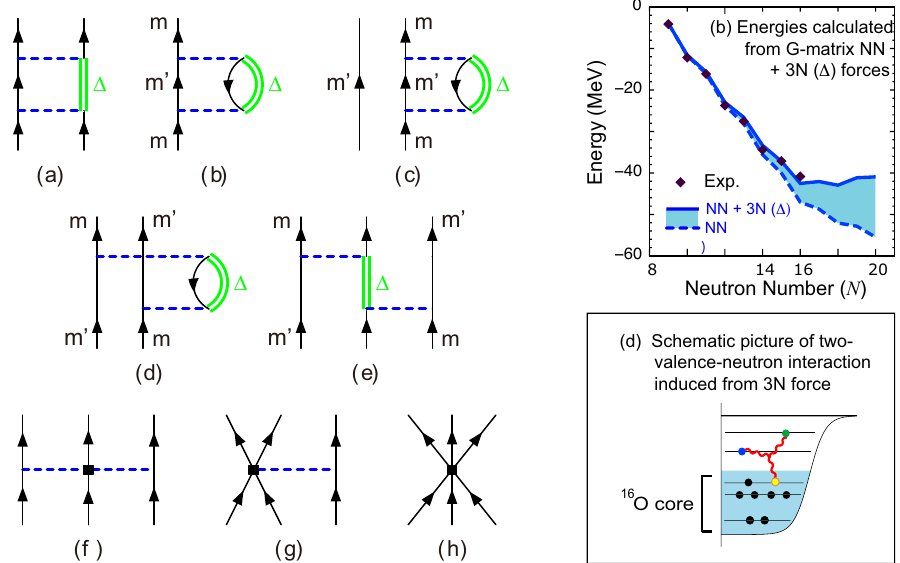
Figure 9. Schematic illustration of the three-nucleon force (3NF). Left : The diagrams ( a – e ) show how ∆ -hole excitation effects are incorporated in accordance with Pauli principles, with the final form shown in ( e ), as described in the text. The diagrams in ( f – h ) represent three contributions from 3NF obtained in the chiral Effective Field Theory. Top right: the ground-state energy of oxygen isotopes, calculated with and without the 3NF and observed experimentally. Bottom right : the intuitive explanation of the diagrams in ( d,e ) of the left panel with the 16 O inert core. Based on Figures 3 and 4 of